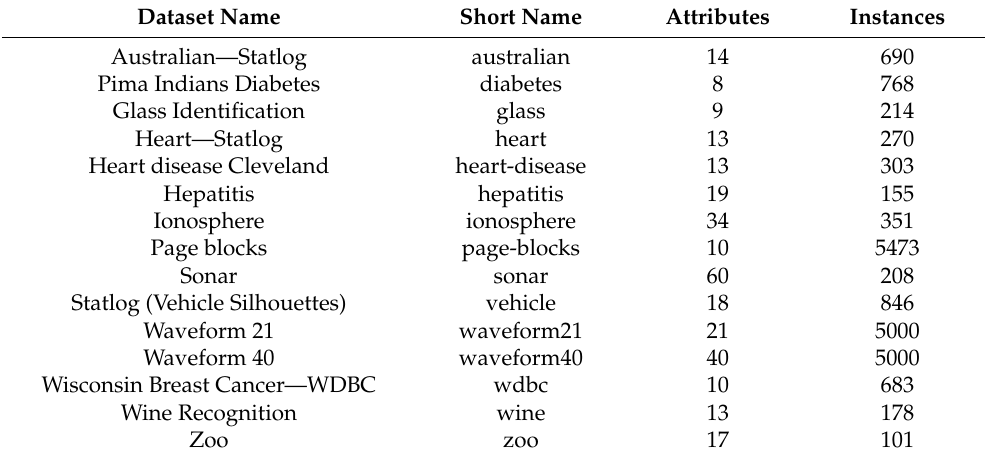
Table 1. Experimental datasets’ basic